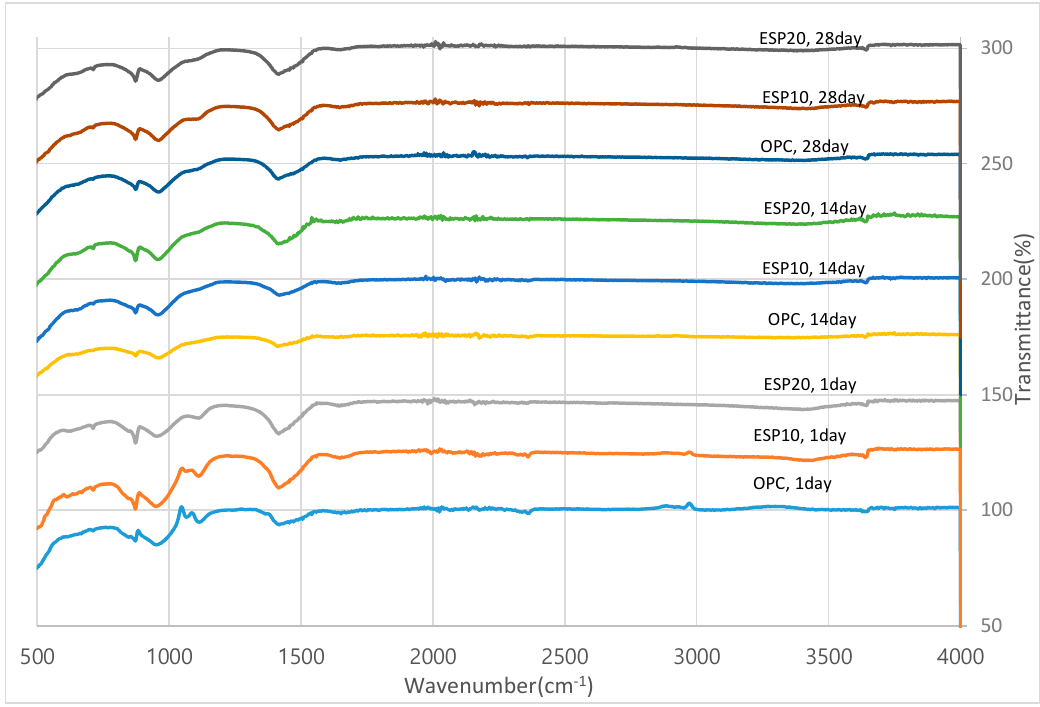
Figure 11. FT-IR results of cement pastes.